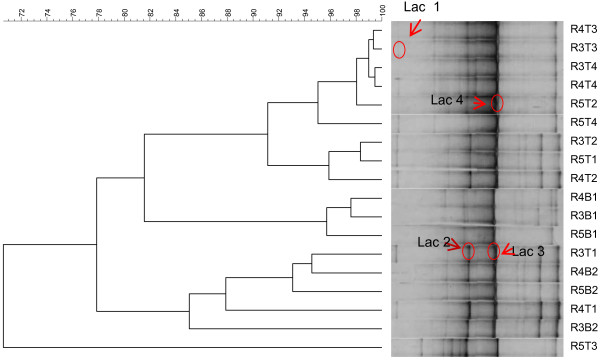
UPGMA dendrogram illustrating the correlation between the different denaturing gradient gel electrophoresis (DGGE) profiles from lactobacillus community obtained from the samples of the SHIME® compartments supplemented with the L. acidophilus CRL 1014 strain throughout model operation. Sequence characterization of the excised fragments indicated the presence of lac 1, L. acidophilus; lac 2, Lactobacillus casei; lac 3, Lactobacillus johnsonii and Lac 4, Lactobacillus sakei. R3: ascending colon, R4: transverse colon, R5: descending colon. B1, and B1: basal period, T1, T2, T3, and T4: treatment period with L. acidophilus 1014.